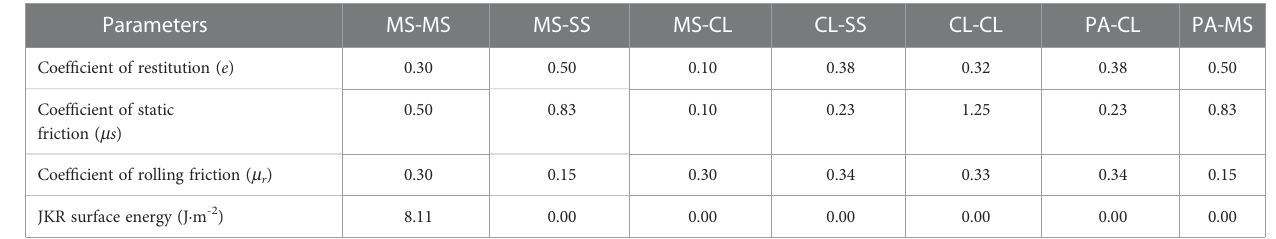
TABLE 2 Simulation contact parameters of different DEM models.